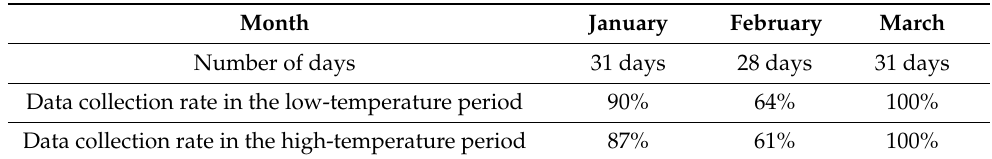
Table 8. Analysis period of pervious road data.